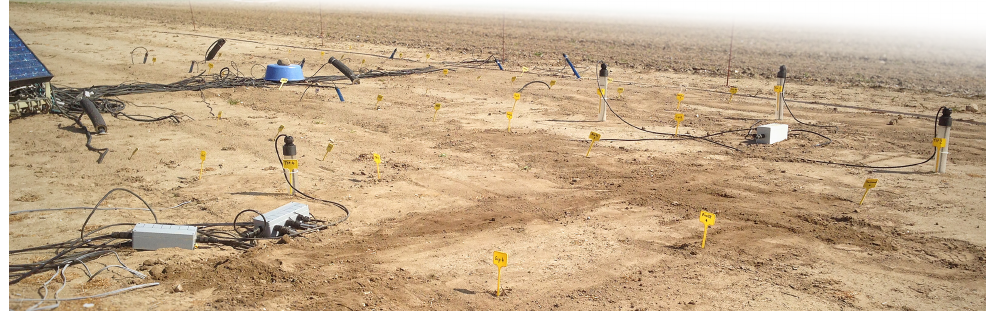
Figure 1. Sensor comparison field site after sensor installation.